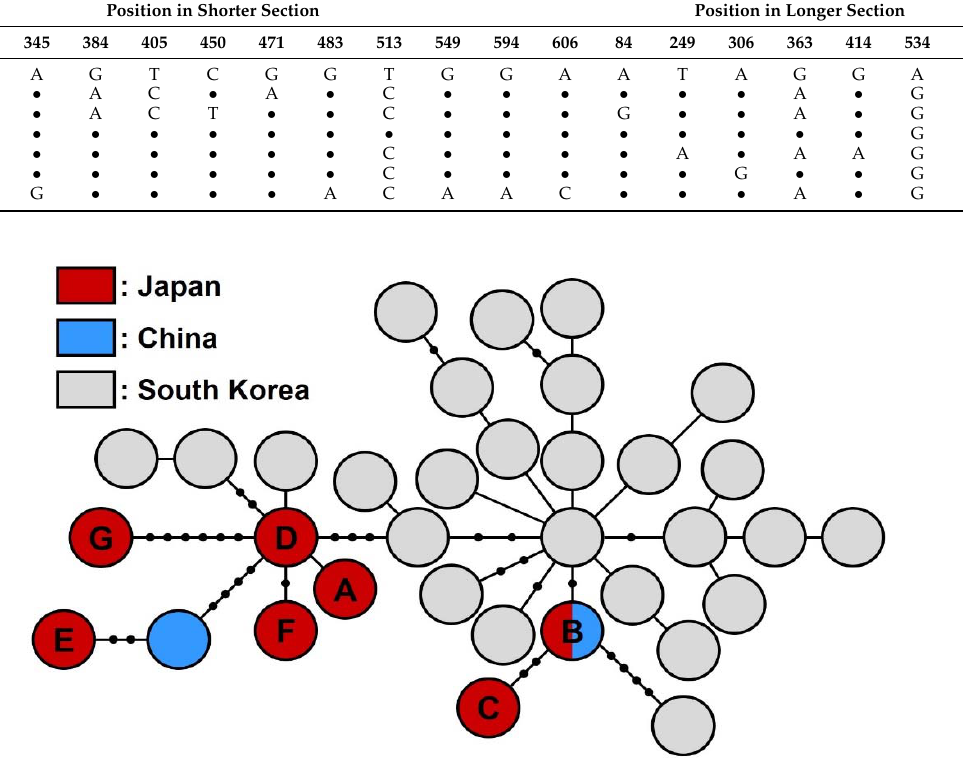
Figure 3. The haplotype network based on mitochondrial CO1 sequences (1170 bp) in Japanese, Chinese, and Korean Aromia bungii . Circles indicate haplotypes detected in this and previous studies. Black dots indicate potential haplotypes that were not collected. The seven haplotypes detected in this study were designated A–G.